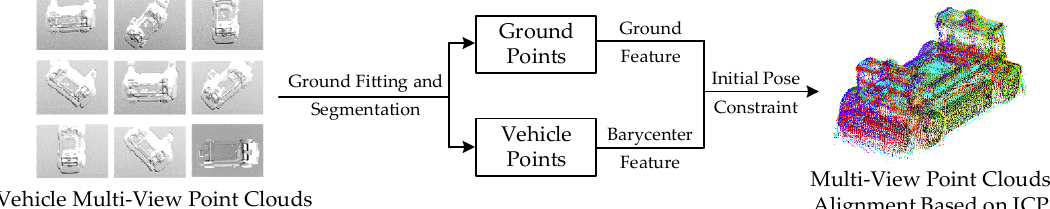
Figure 14. The splicing procedure for template point cloud acquisition. 50% overlap between the adjacent point clouds. The ground normal features and vehicle barycenter features were extracted for pose initialization. The template point cloud after ICP alignment is shown in Figure 14, where different colors represent point clouds from different perspectives. After density adjustment and aligning with the origin of the global coordinate system, the completed template point cloud of the experimental vehicle is shown in Figure 15.